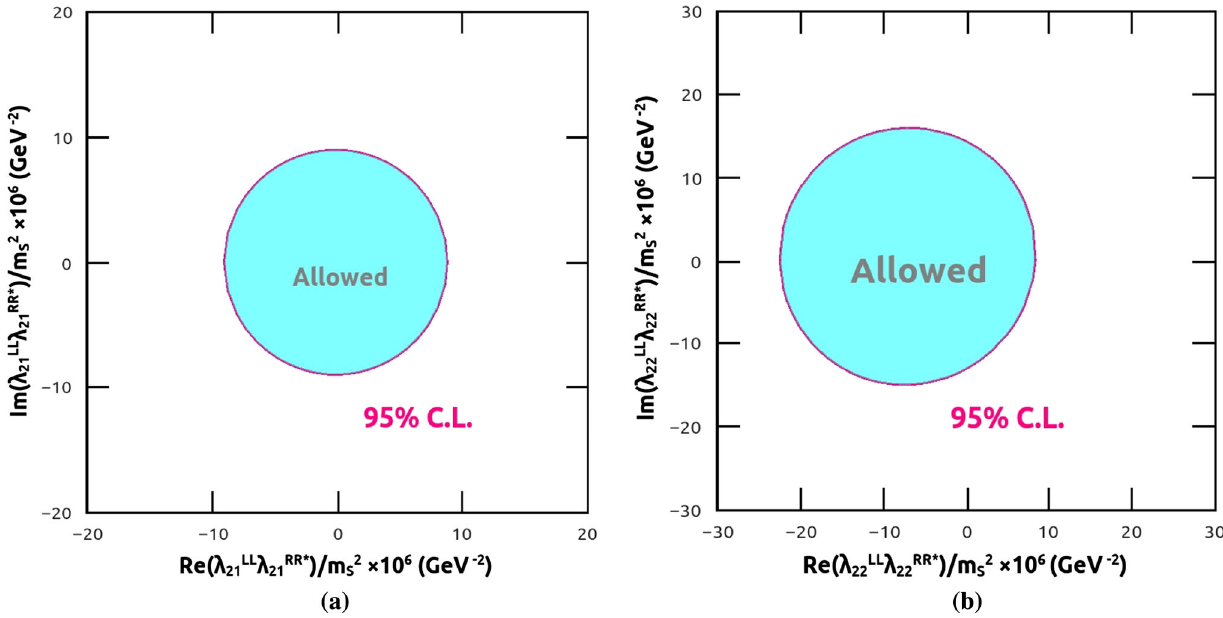
λ RR ∗ / m 2 for the electron case and b λ LL S 0 21 21